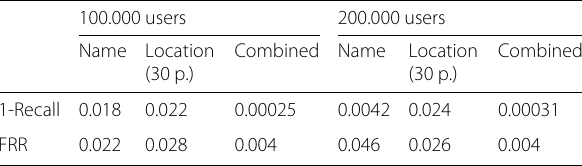
Table 1 Recall and FRR at FAR = 0.00164, k = 50 for different filters and population sizes 100.000 users